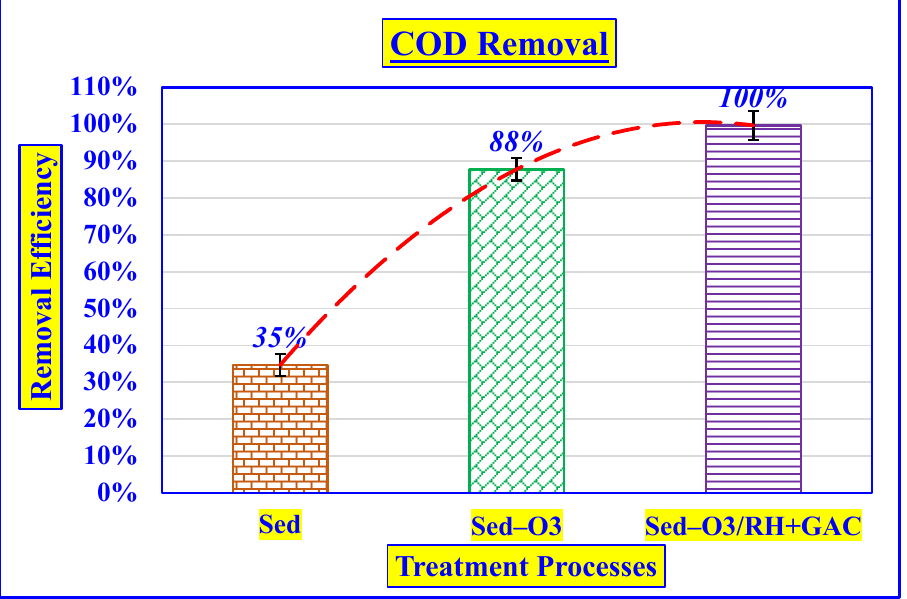
Figure 7. COD removal by hybrid system (Initial COD = 490 ± 11.5 mg/L; O 3 = 82.5 ± 2.2 mg/L; peristaltic pump speed = 150 rpm; C.T = 18 min; GAC = 200 g; RH = 200 g; pH = 6.9 ± 0.2; volume = 4 L; T = 25 ± 2 C).